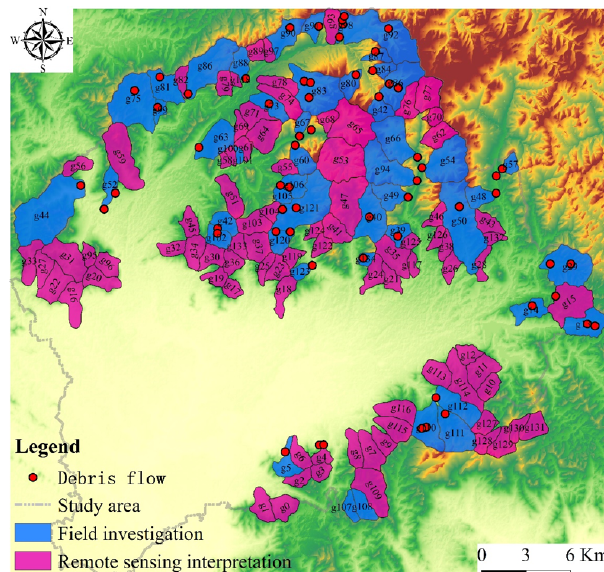
Figure 4. Debris flow basin division and inventory. Note: the data of debris flow points come from the Beijing Municipal Commission of Planning and Natural Resources websites (Beijing Municipal Com- mission of Planning and Natural Resources,